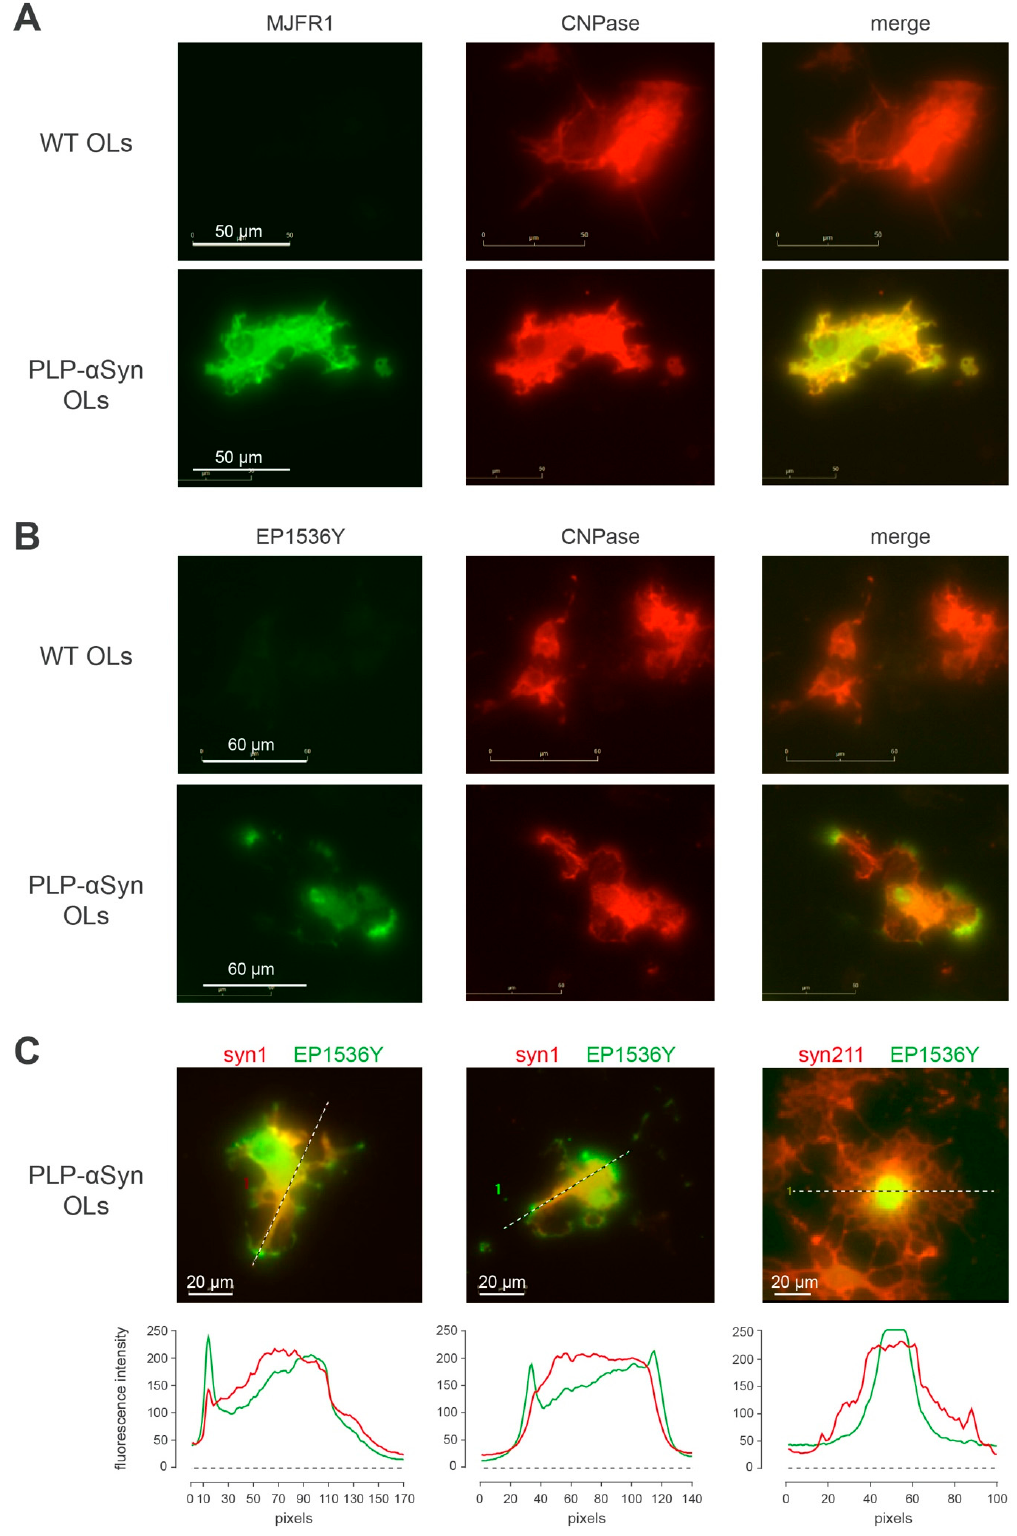
Figure 5. pS129 positive human α -syn is enriched in OL processes ( A ) Representative immunofluorescence imaging of 2 (cid:48) ,3 (cid:48) -cyclic-nucleotide 3 (cid:48) -phosphodiesterase (CNPase, red) together with human α -syn (MJFR1, green) in primary cultures of OLs from PLP- α Syn mice and wt mice. ( B ) Representative immunofluorescence imaging of 2 (cid:48) ,3 (cid:48) -cyclic-nucleotide 3 (cid:48)